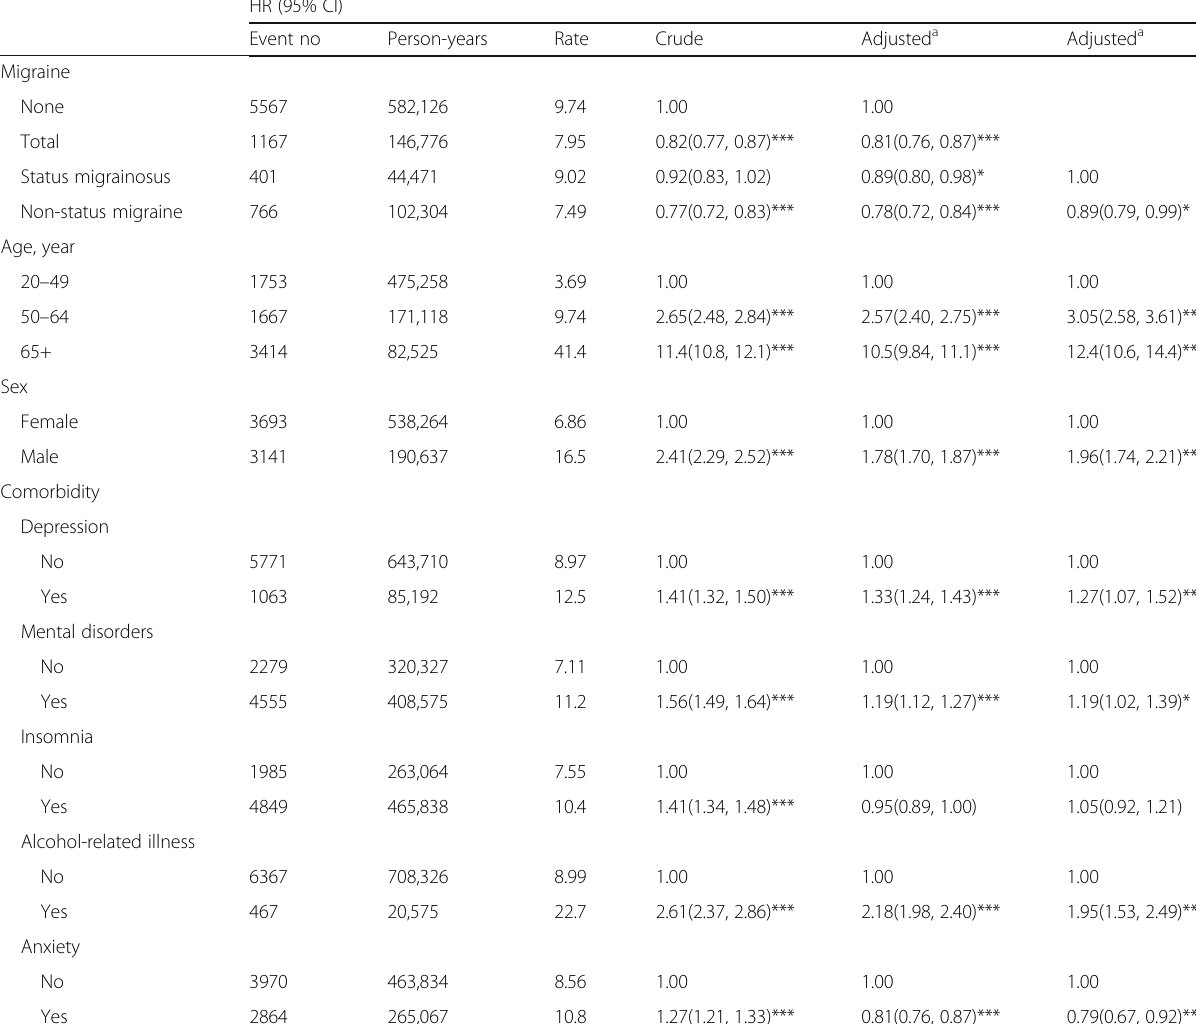
Table 2 Incidence and hazard ratios of mortality and associated risk